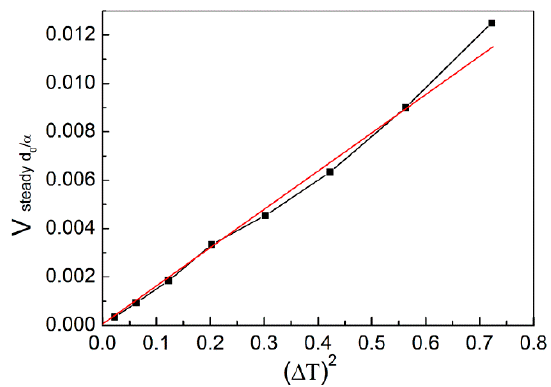
Figure 3. The relationship between crystal growth rate and the square of supercooling degree.